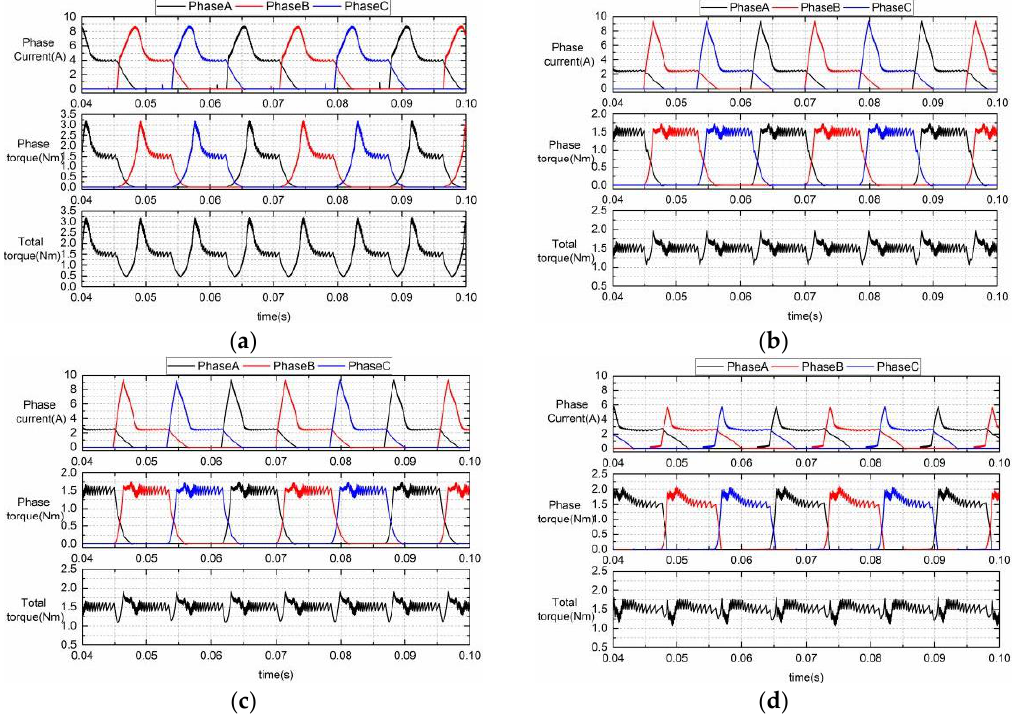
Figure 12. Simulation results ( T ref = 1.5 Nm, 3000 rpm): ( a ) CCC; ( b ) Linear TSF; ( c ) Sinusoidal TSF; ( d ) TSF1 ( r = 4).